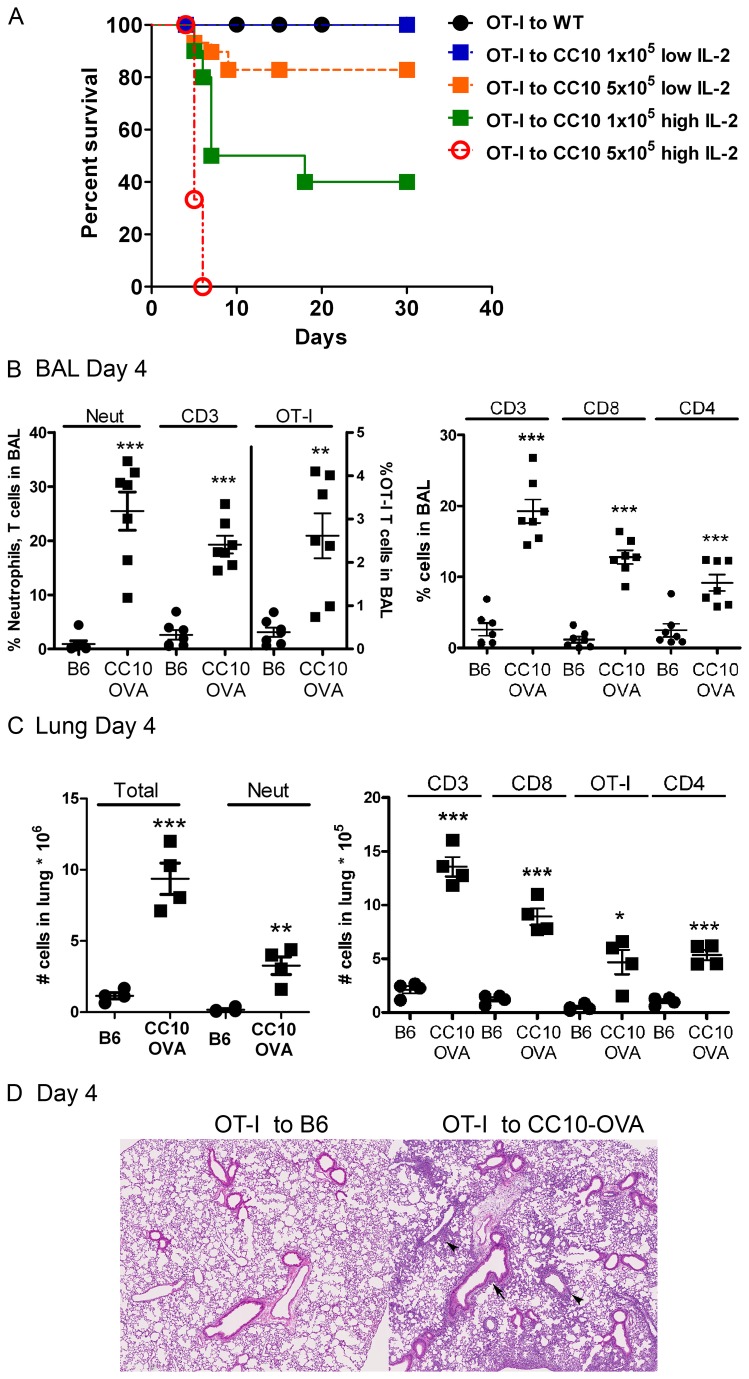
Acute lung inflammation induced by antigen-specific CD8+ T cells cultured with low dose IL-2 resolves.CC10-OVA. Thy1.2 transgenic mice or controls (B6.Thy1.2) were injected i.v. with the indicated numbers of activated OT-I. Thy1.1 T cells expanded with either high dose IL-2 (25U/ml) or low dose IL-2 (12.5U/ml). (A) Survival was dependent on the number of OT-I transferred and the dose of IL-2 given during culture. (B) The percentage of neutrophils (gated by size and Gr1Hi), CD3+Thy1.2+ and OT-I. Thy1.1+ T cells were measured in the BAL. (C) The numbers of cells in the lungs were measured on Day 4 after transfer of OT-I T cells. (D) Lung histology 4 days after transfer demonstrates peribronchial and perivascular mononuclear infiltrates in CC10-OVA mice compared to B6 mice; 7 µm sections were stained with H and E, magnification, 10X. Unpaired t tests were used to determine significance between controls (B6) and CC10-OVA mice, *p<0.05, **p<0.01, ***p<0.0001.